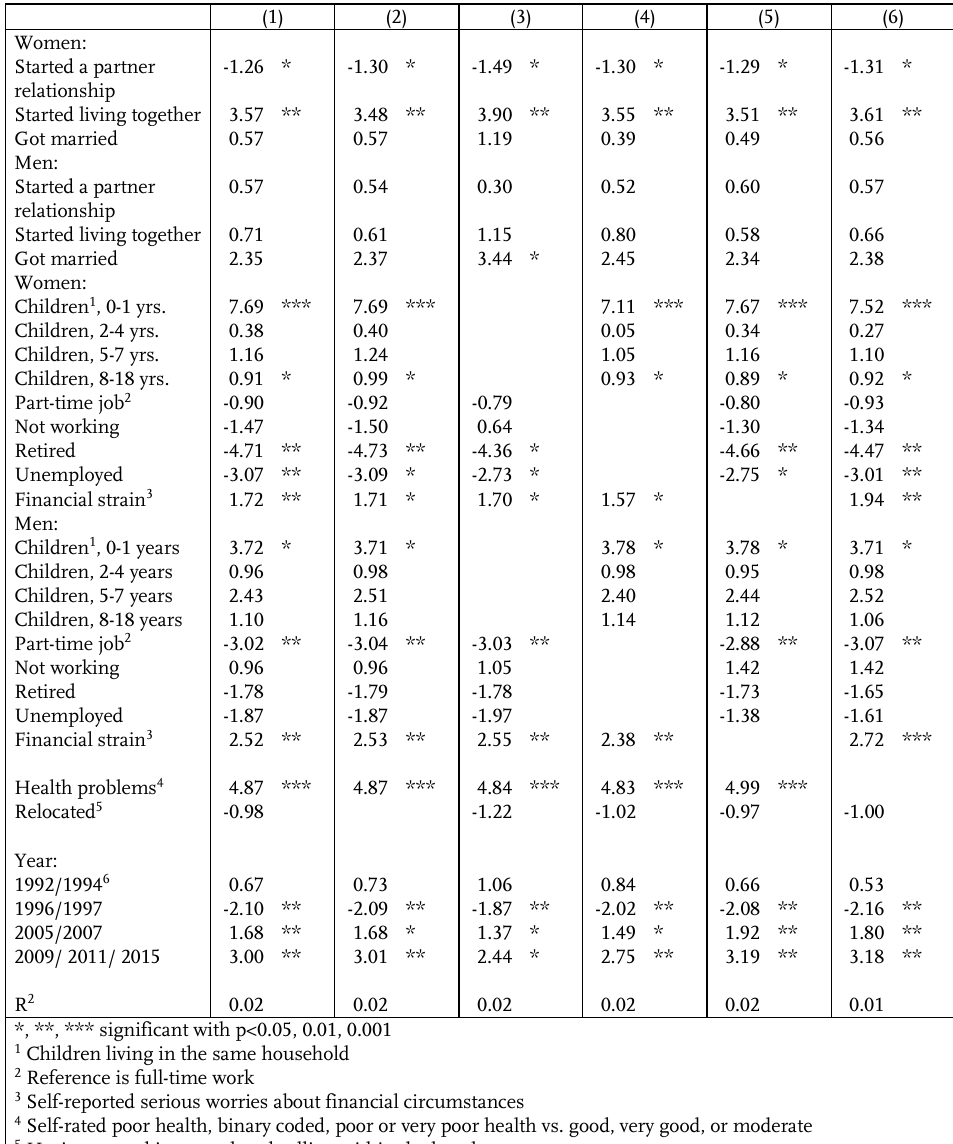
Table A.2 : Effects of partner relationships, children, employment, relocations, health and financial strain on absence of secondary-sphere contacts (disconnectedness from friends and relatives; linear- probability models with fixed effects, percentage